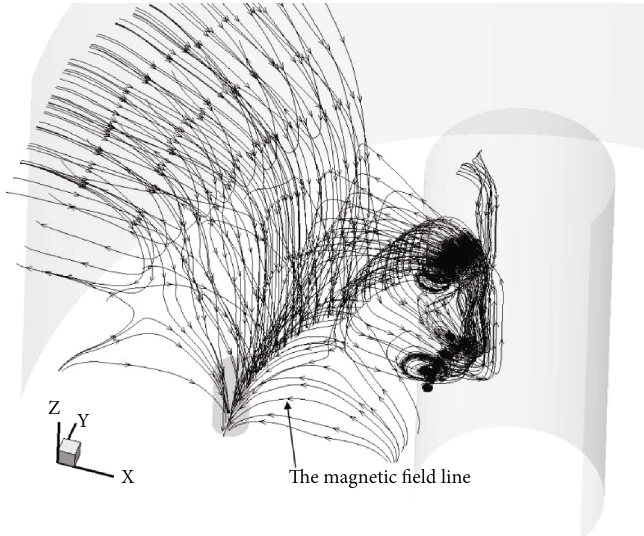
The magnetic field Figure 24: 3D view of magnetic fi eld line near cathode.